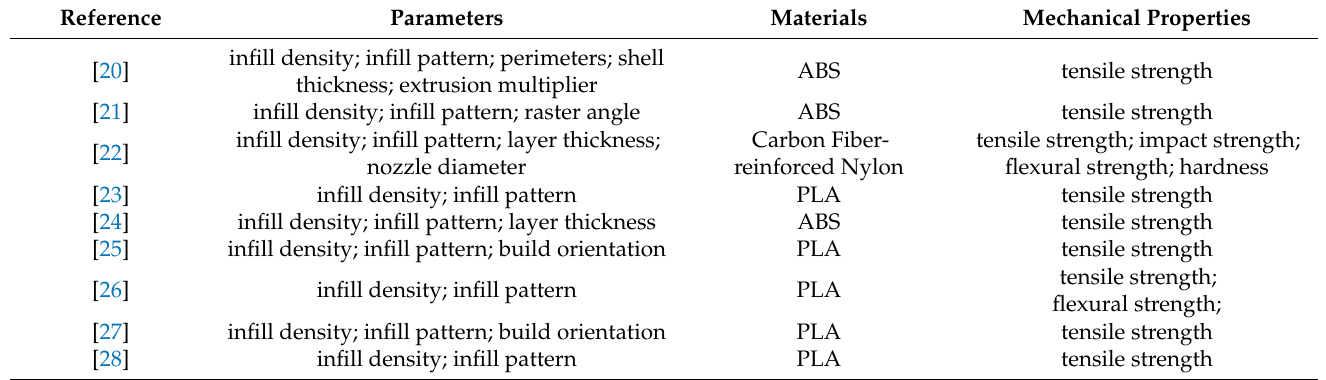
Table 2. Summary of previous literature related to infill pattern and density. Reference Mechanical